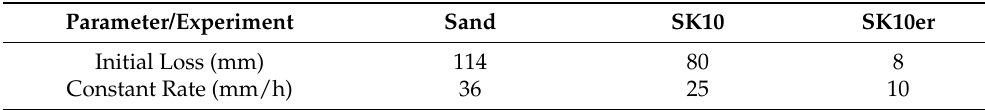
Table 9. Calibrated values of parameters for different experiments using the initial and constant method. Initial values are shown in Table 4.